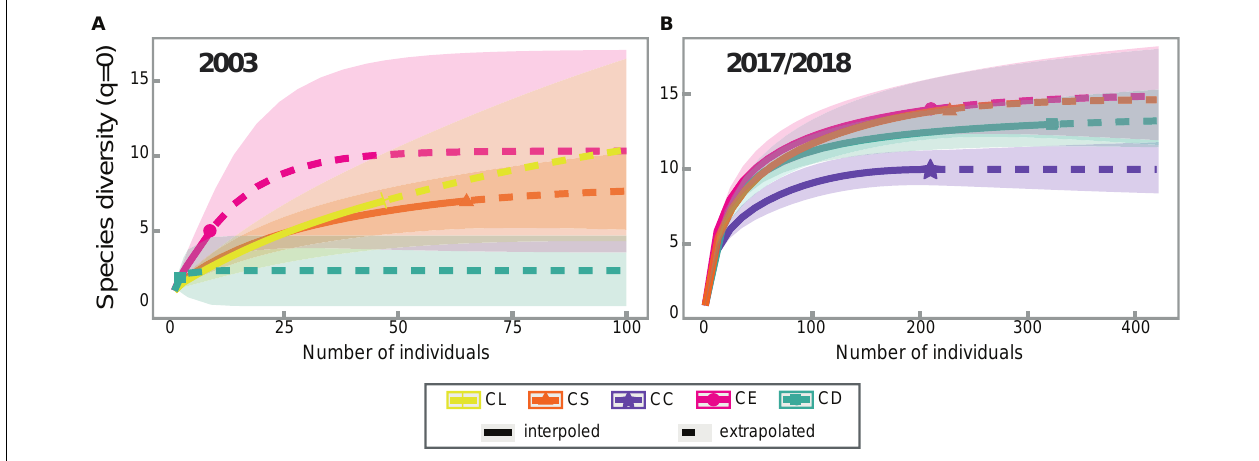
FIGURE 1 | Rarefaction/Extrapolation curves for (A) the 2003 survey generated with 1,000 bootstraps and 100 individuals as endpoint and for (B) the 2017–2018 survey generated with 1,000 bootstraps and 420 individuals as endpoint. The shadow surface represents the 95% confidence interval for each curve. The